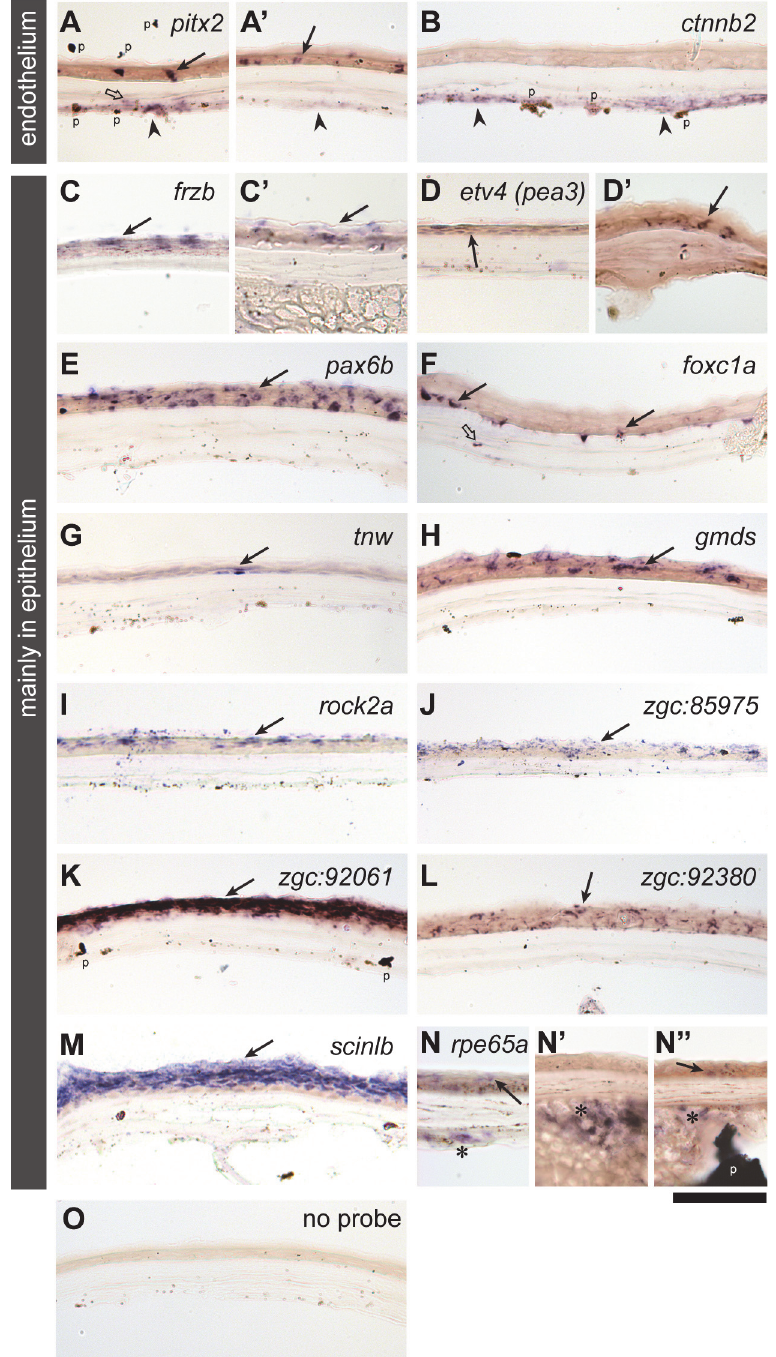
Fig 2. In situ mRNA expression analysis in the adult zebrafish cornea. Two major classes of expression patterns are shown for selected genes: genes mainly expressed in the corneal endothelium ( paired-like homeodomain 2 (A-A ’ ) and catenin, beta 2 (B)) and mainly in the corneal epithelium ( frizzled-related protein (C), ets variant 4 (previously known as pea3 , D-D ’ ), paired box 6b (E), forkhead box C1a (F), tenascin W (G), GDP-mannose 4 , 6-dehydratase (H), rho-associated, coiled-coil containing protein kinase 2a (I), zgc : 85975 (J), zgc : 92061 (K), zgc : 92380 (L), scinderin like b (M) and retinal pigment epithelium-specific protein 65a (N- N ” ). A control without probe is shown in the panel O. Filled arrows, open arrows, arrowheads and asterisks indicate expression in the corneal epithelial, stromal, endothelial layers and the annular